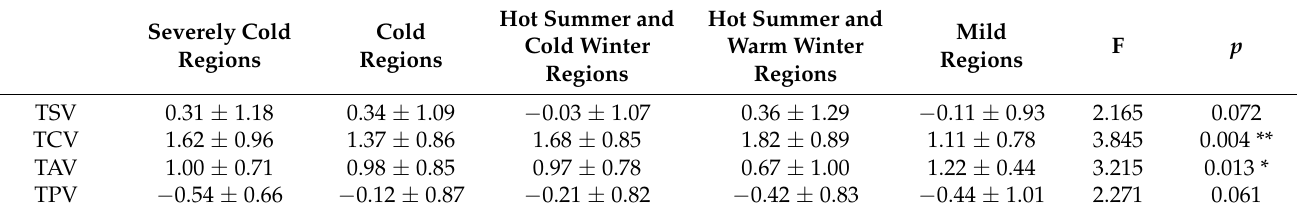
Table 11. Difference analysis of long-term residence and weather perception. Hot Summer and Hot Summer and Severely Cold Cold Warm Winter Cold Winter Regions Regions Regions Regions